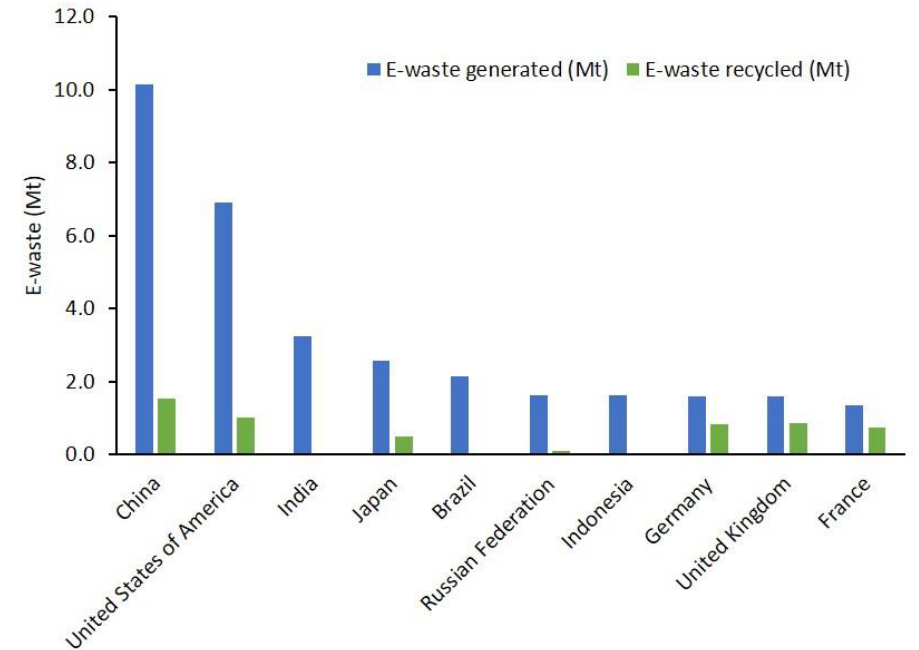
Figure 2. Annual generation of e-waste in top ten countries and the corresponding recycling data from Forti, 2018 [5].